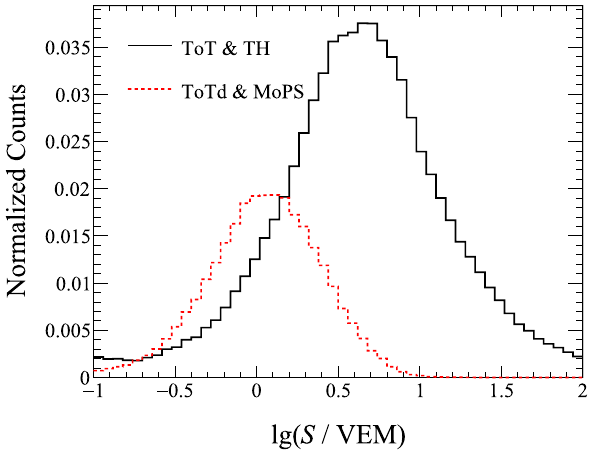
Fig. 4 Distributions of start times with respect to a plane front for stations that pass the ToT and TH algorithms, in blue and in green, respectively. The signals due to ToTd and MoPS are shown in red. Positive residuals correspond to a delay with respect to the plane wave